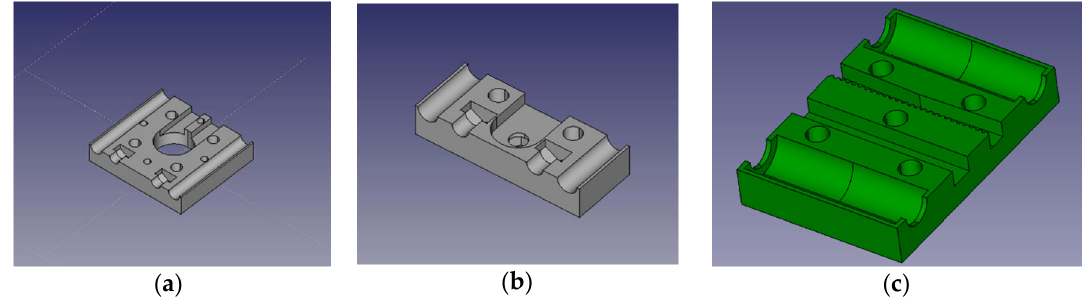
Figure 2. The 3-D printed component models for the D3D design system. The rendered designs of the ( a ) motor mounting block, ( b ) bearing mount block, and ( c ) carriage block are shown.